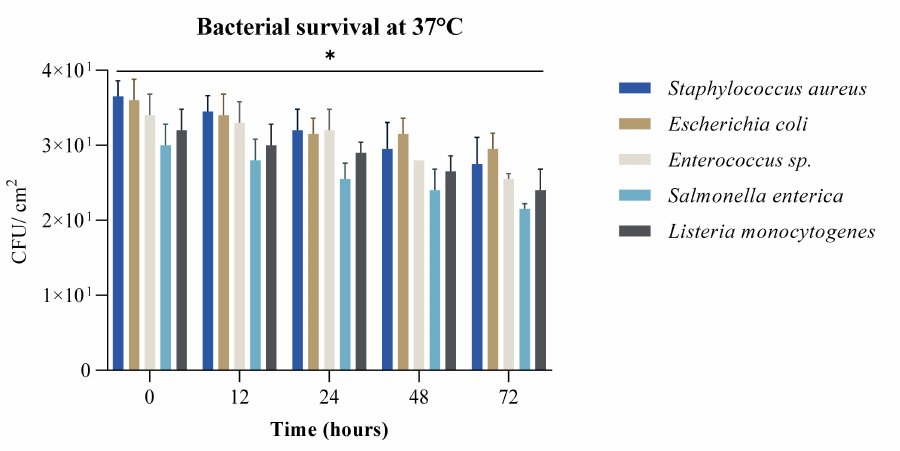
Figure 2. Bacterial survival recorded as CFU/cm2 at 37 ◦ C, 65% humidity, on various banknotes at five time points (0 h, 12 h, 24 h, 48 h and 72 h) (* p -value =